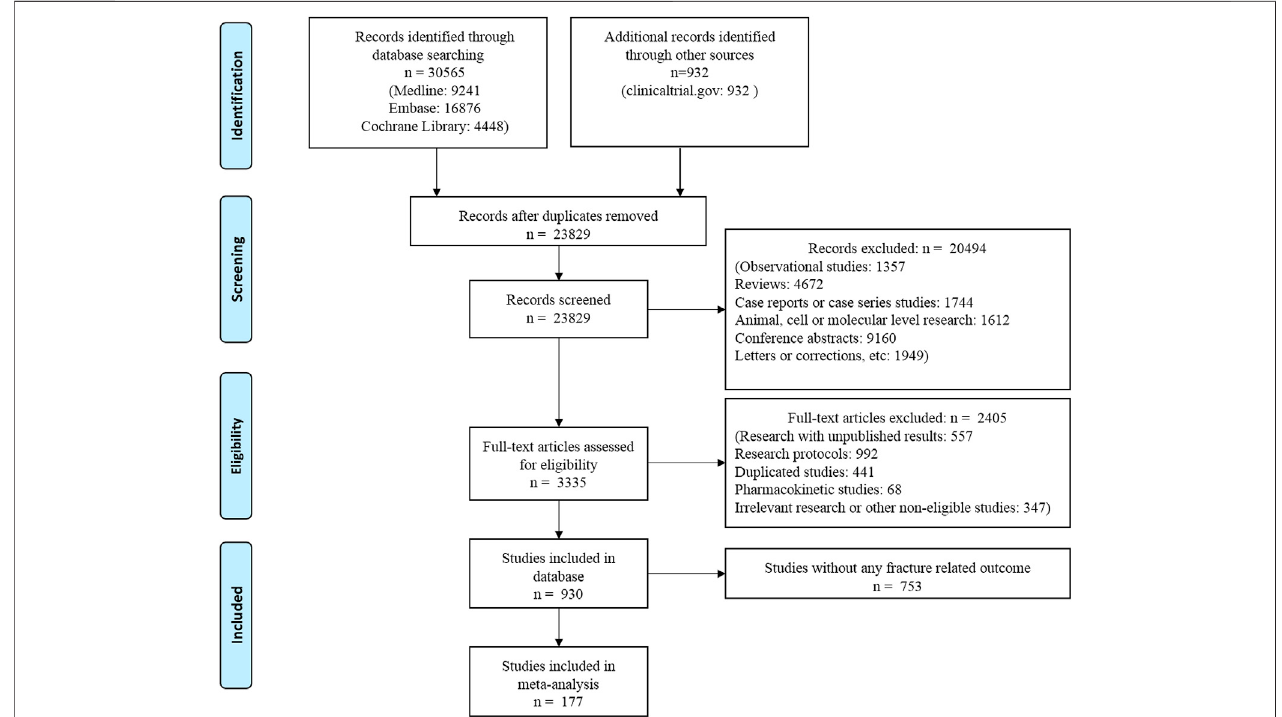
FIGURE 1 | Flow chart of studies considered for